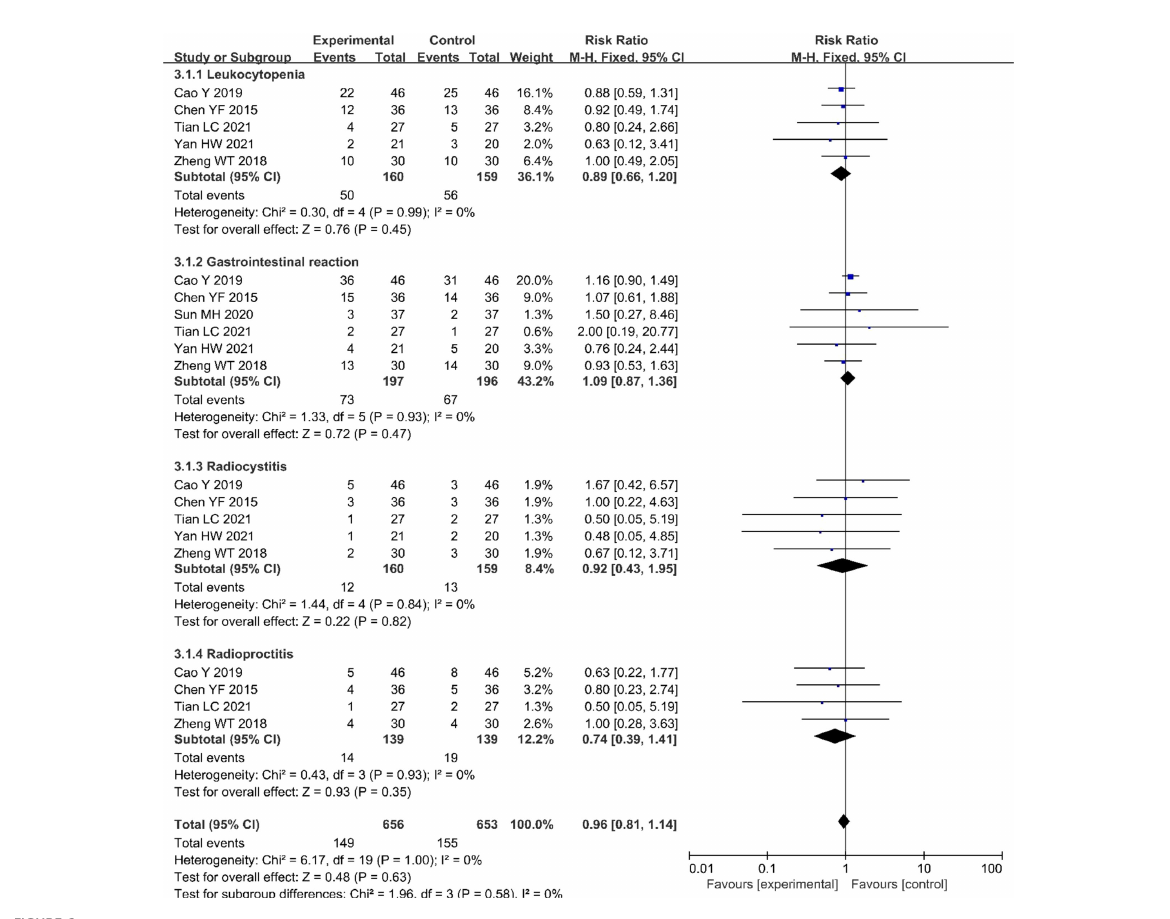
FIGURE 6 Forest plot for adverse reactions of nimotuzumab combined with CRT group and CRT alone group. CRT,